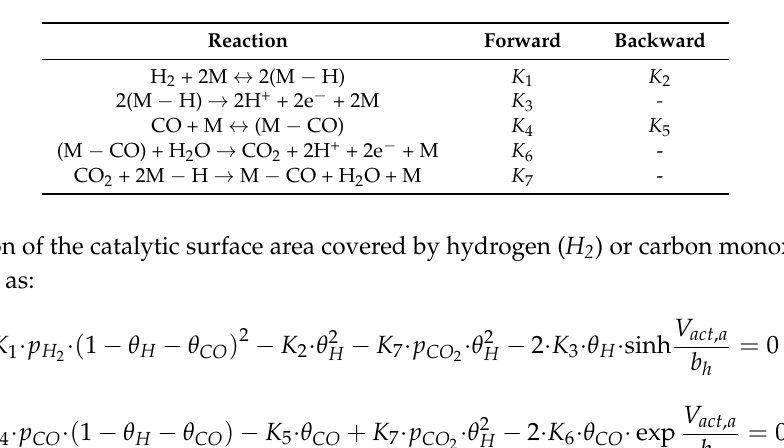
Table 1. Forward and backward reaction